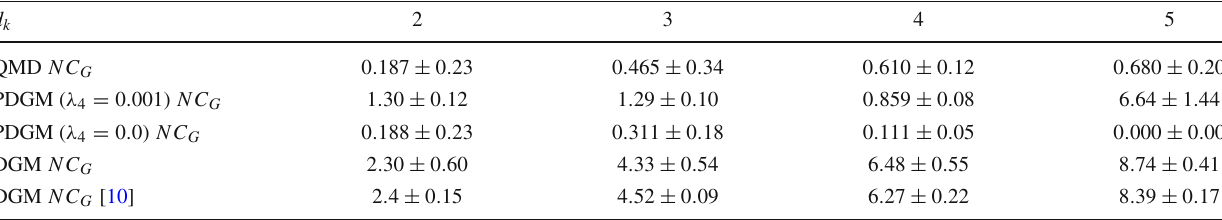
Table 1 Values of clustering coefficient, multiplied by network size for N = 100 for QMD, DGM and both variants of PDGM. The significant reductioninclusteringintheQMDandPDGMmodelsareevident.Also d